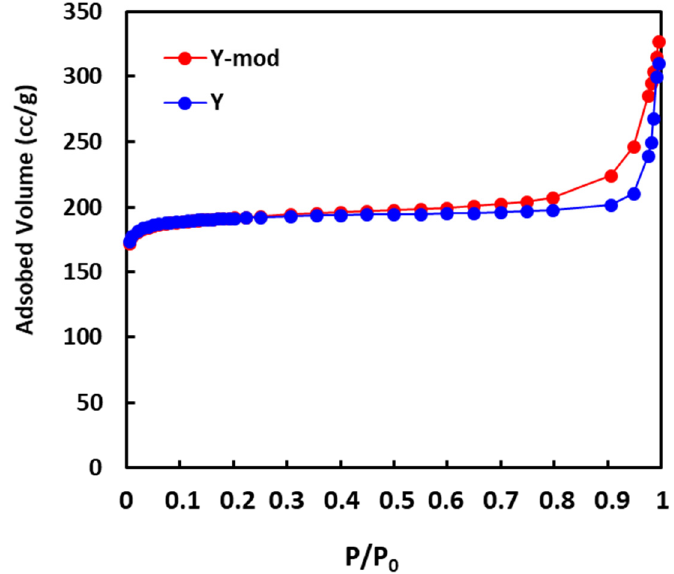
Figure 2. Adsorption isotherms of N 2 of Y zeolite and Y ‐ mod zeolite.